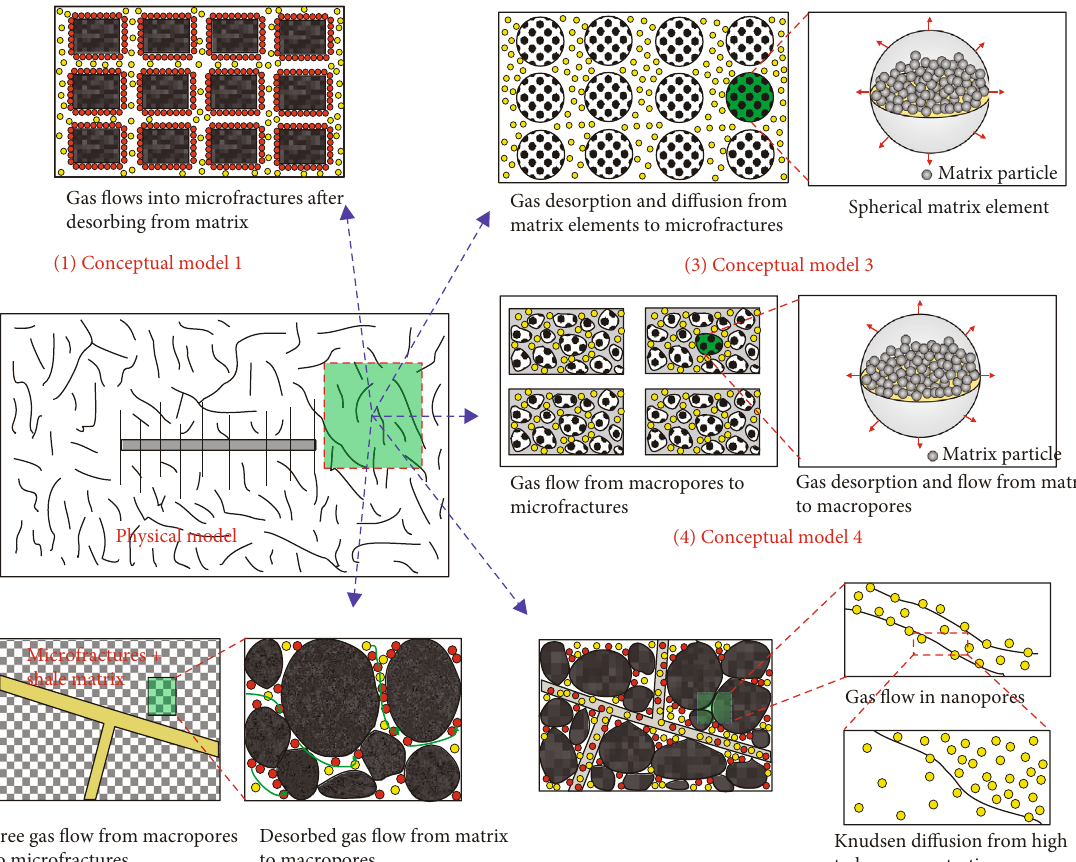
Figure 10: Conceptual models for gas transport mechanisms in shale gas reservoirs [1].